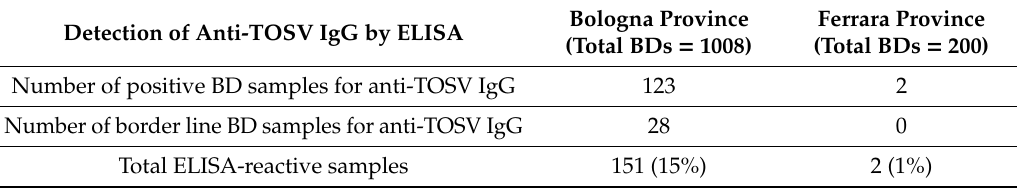
Bologna Province